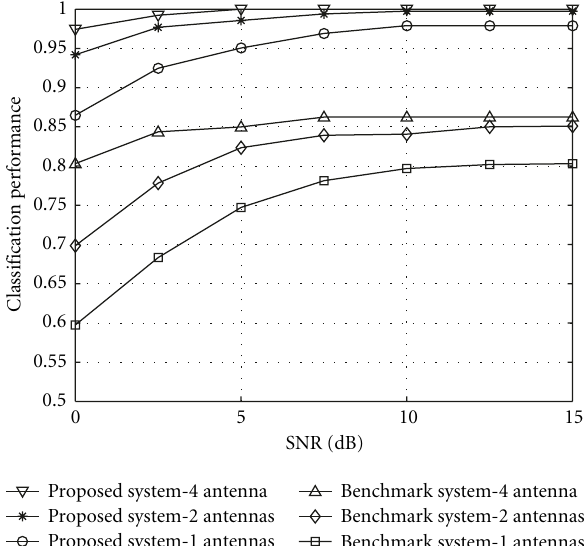
Figure 12: Classification performance of proposed initial SOF- based classification stage and benchmark in a slow two-path fading channel using the MRC-variant combining scheme.